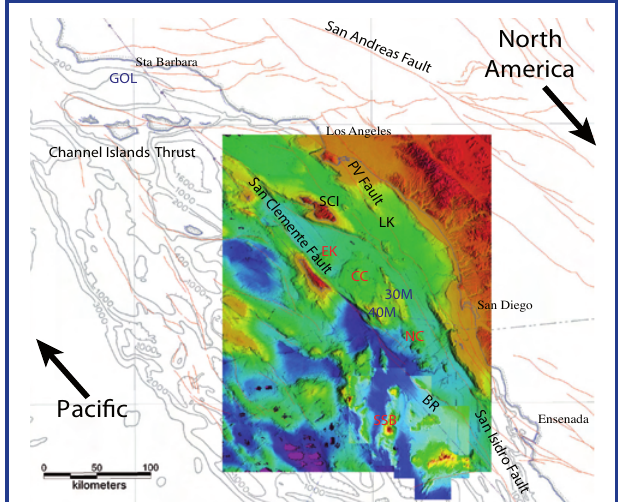
Figure 11. Geology, bathymetry, and topography of the California Borderlands, showing representative geologic hazards and fea- tures (figure courtesy of Mark Legg). Volcanic features (red) include Emery Knoll (EK), Catalina Crater (CC), Navy Crater (NC), and South San Clemente Basin (SSB). Tectonic features (black) include Santa Catalina Island (SCI), Lasuen Knoll (LK), and Palos Verdes (PV). Potentially tsunamigenic landslides (blue): Fortymile Bank (40M), Thirtymile Bank (30M), and Goleta Slide